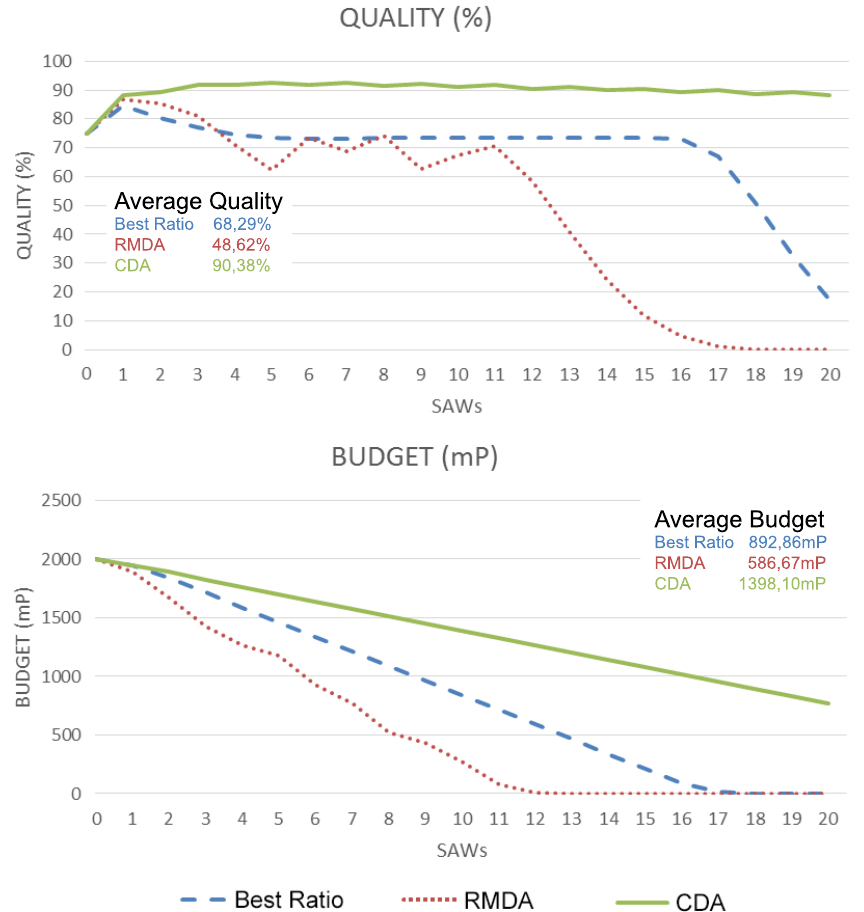
Figure 6. Auction-based comparison results under high budget